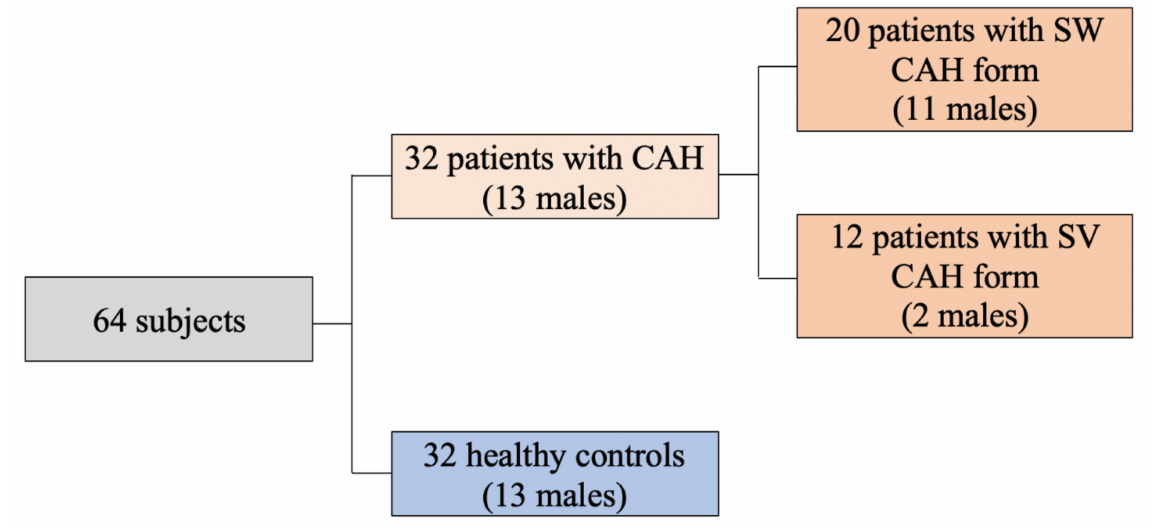
Figure 1. Descriptive scheme of study subjects.